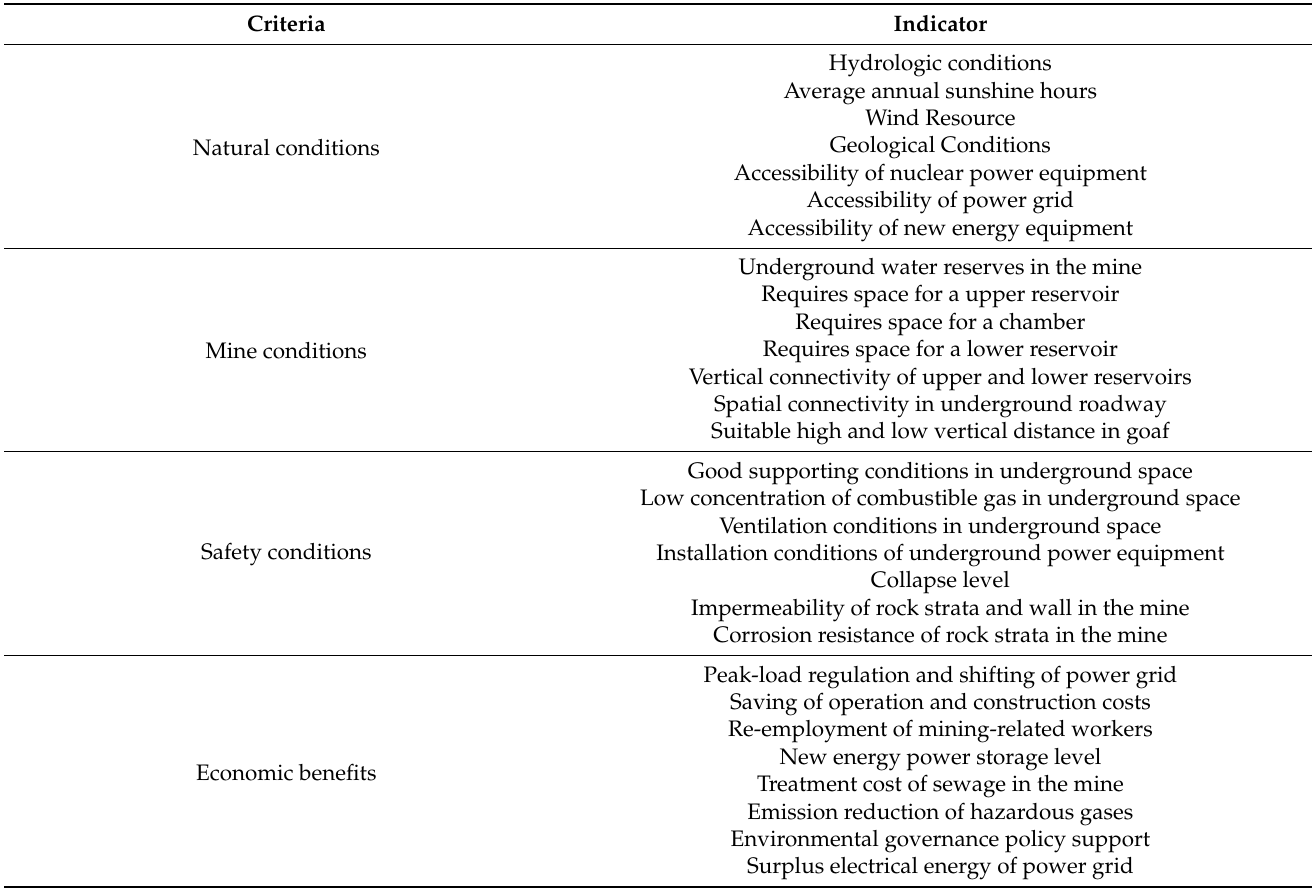
Table 1. Feasibility indicators for abandoned-mine pumped